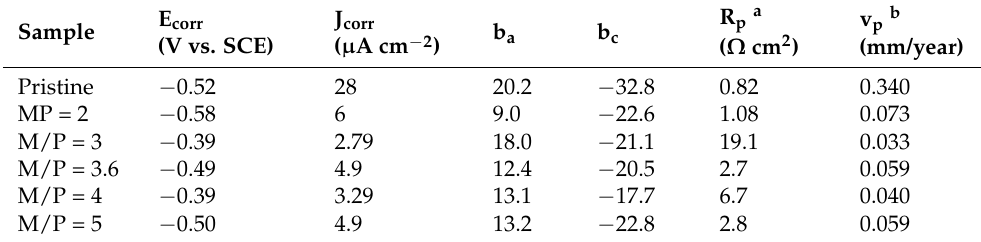
Figure 3. Potentiodynamic polarization for corrosion testing of MgKPO 4 ·6H 2 O at different magne- sia/KH 2 PO 4 molar ratios. magnesia/KH 2 PO 4 molar ratios. Table 3. Calculated parameters of MgKPO 4 ·6H 2 O at different magnesia/KH 2 PO 4 molar ratios. Table 3. Calculated parameters of MgKPO 4 · 6H 2 O at different magnesia/KH 2 PO 4 molar